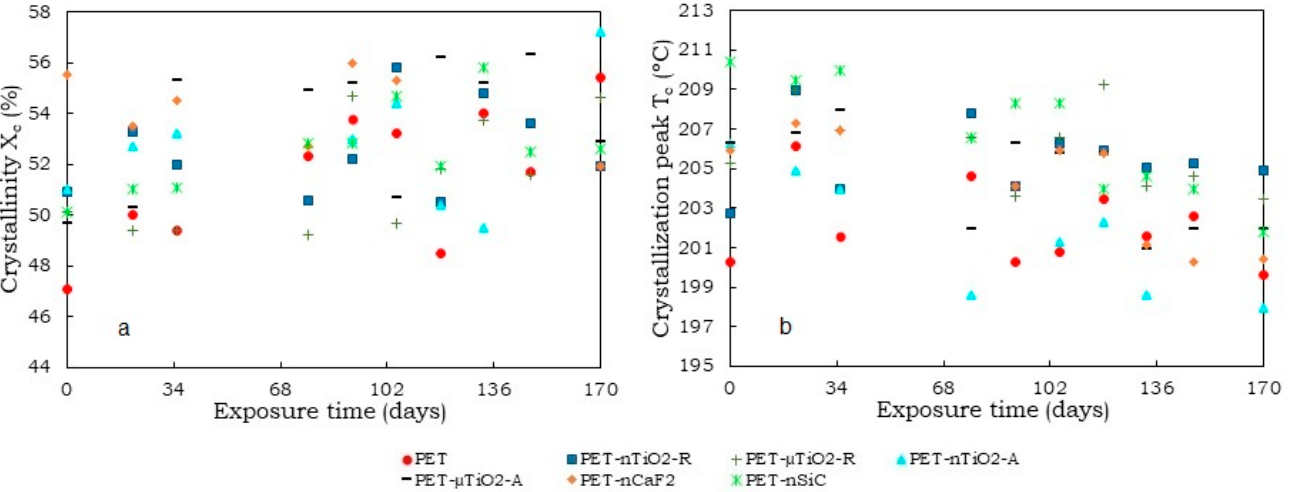
Figure 7. ( a ) Crystallinity of yarns (1st heating) and ( b ) Crystallization peak of yarns as a function of the exposure time.